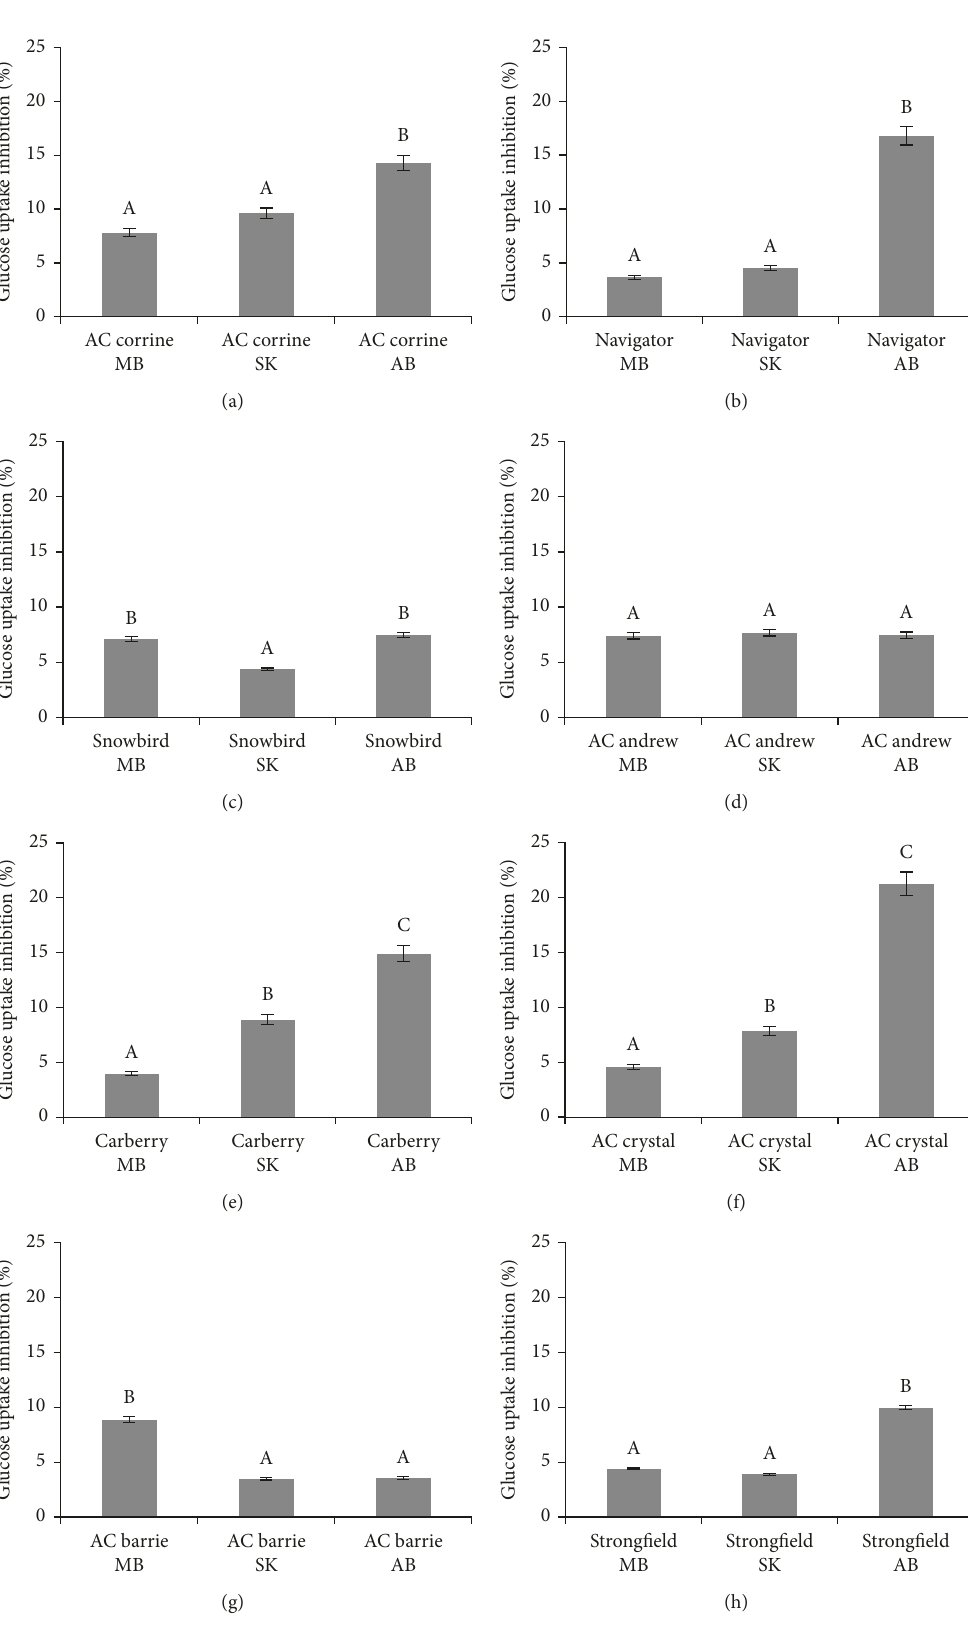
Figure 4: Relative inhibition of the uptake of [ 3 H] 2-deoxyglucose into CaCo-2 monolayers caused by extracts of bond phenolic acids obtained from eight wheat genotypes (a–h) grown in MB, SK, and AB over 2010 crop year. A,B,C Different capital letter superscripts indicate significant differences ( P 0 . <